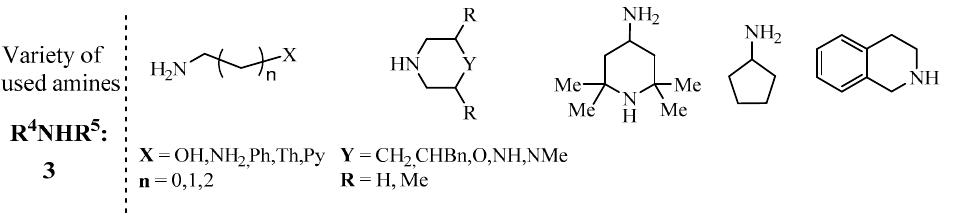
Figure 2. A variety of successfully used amines in the synthesis of thieno[3,2- d ]pyrimidin-4(3 H )-one thieno[2,3- d ]pyrimidin-4(3 H )-one 5a – z derivatives.